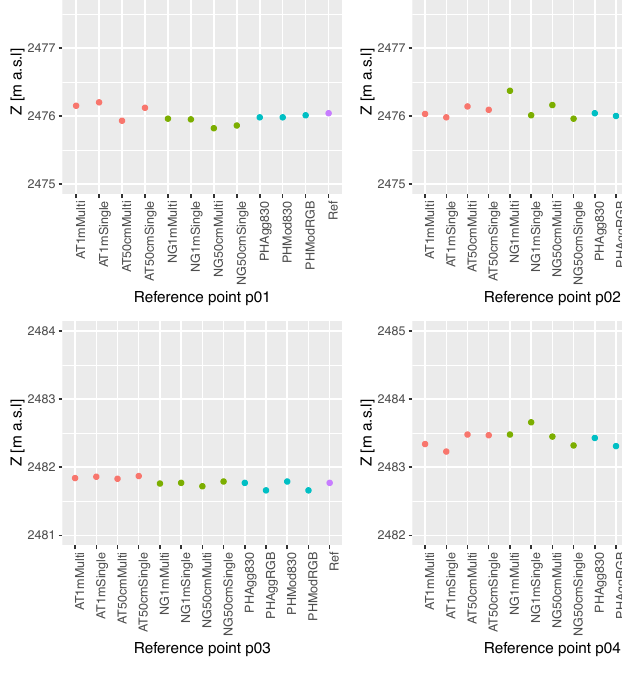
Figure 5. Difference (point cloud - reference point) Each boxplot "Difference" (Figure 5) is calculated as